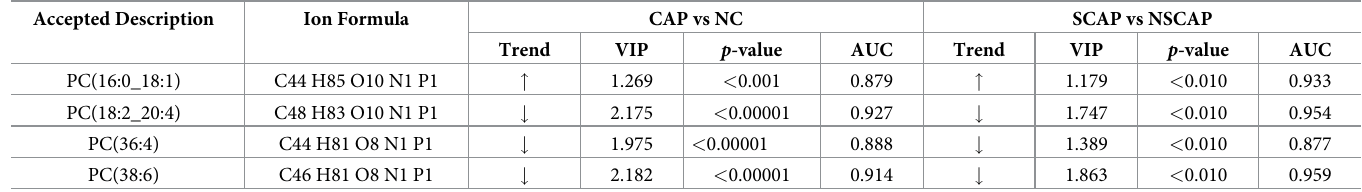
Table 3. Comparison results of four different lipids meeting the screening